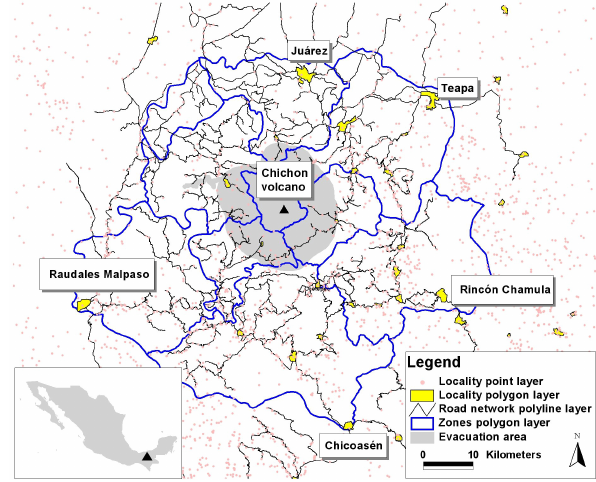
Fig. 12. Location map of El Chich ´ on volcano. The evacuation area is obtained from impact scenarios simulated by VORIS (Felpeto et al., 2007) plus a security zone of 3.5km. The number of people liv- ing in the evacuated area is 17918. The arrival points are different towns located 30km far away from the volcano (Juarez, Teapa, Rin- con Chamula, Chicoasen and Raudales Malpaso). The working area has been divided in nine zones. Since this is not an example in a de- tailed scale, the information concerning the population is contained in a localities point